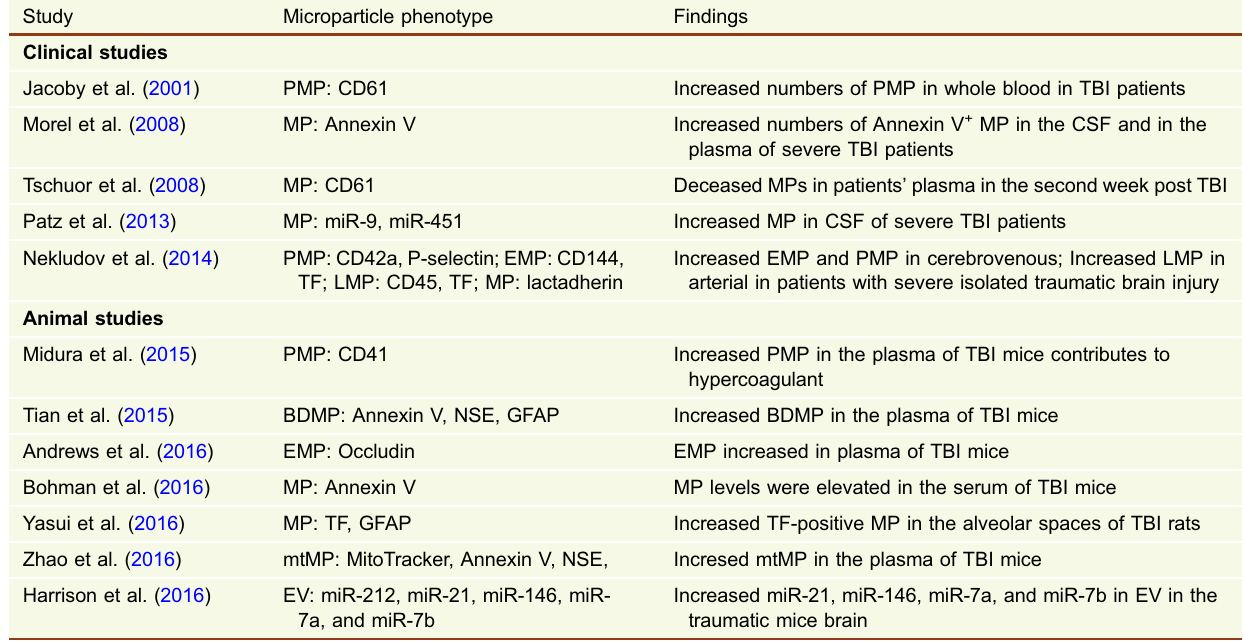
Table 1. Microparticles as biomarkers of traumatic brain injury: studies and fi ndings